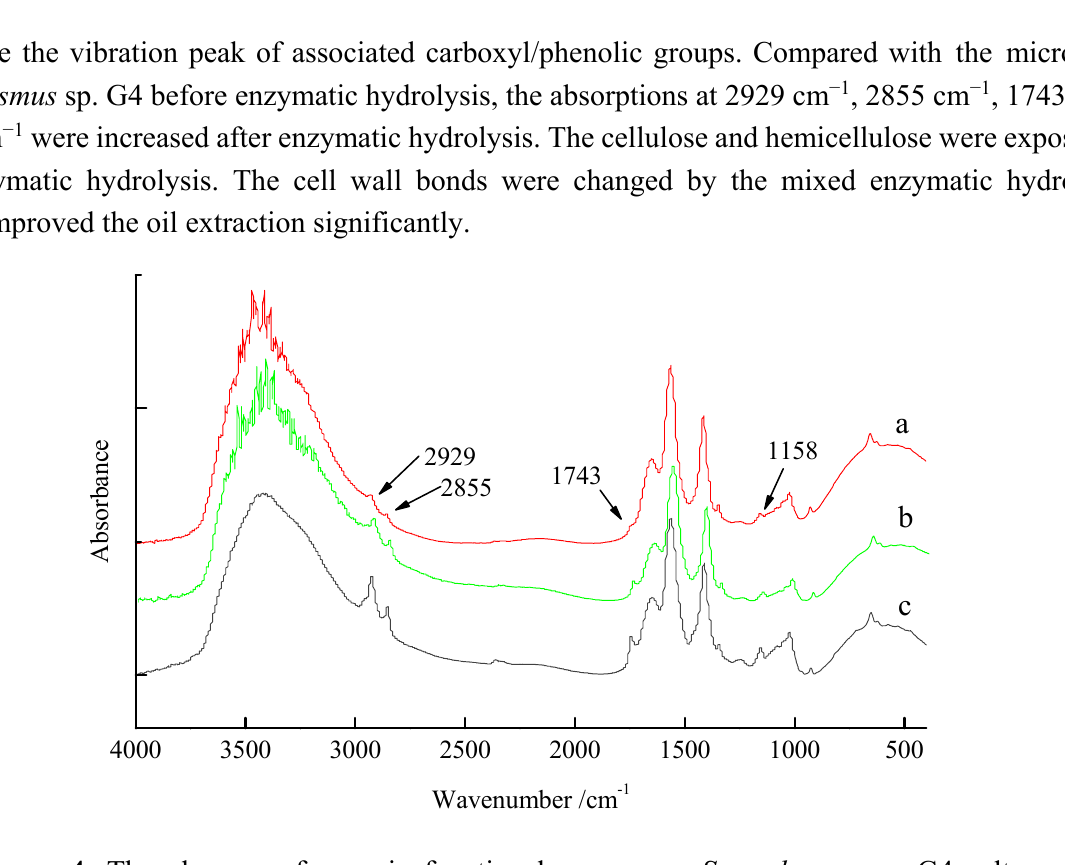
Figure 4. The changes of organic functional groups on Scenedesmus sp. G4 cultures: ( a ) before enzyme hydrolysis; ( b ) hydrolyzed by enzyme mixtures 60 h, pH = 4.5; and ( c ) hydrolyzed by enzyme mixtures 60 h, pH =